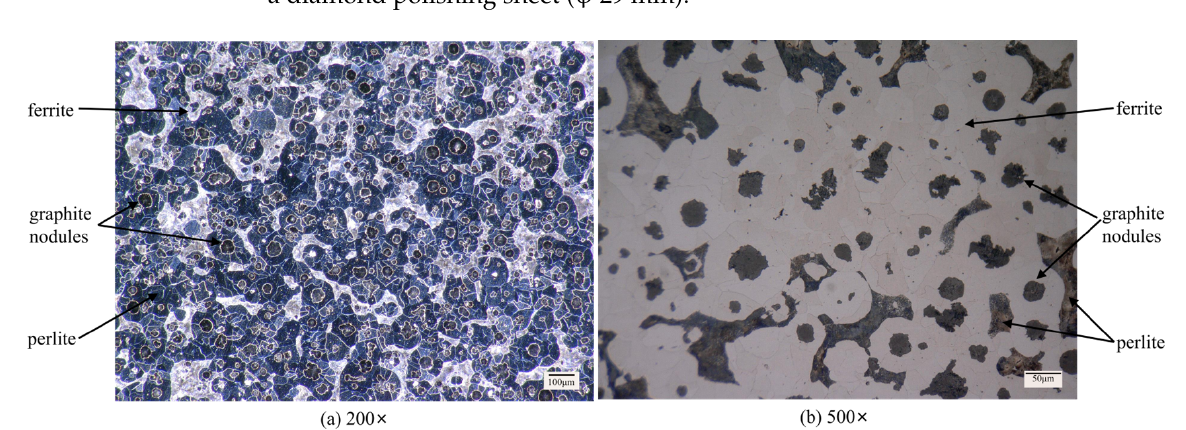
Figure 1. Microstructure of nodular cast iron QT700-2: ( a ) 200×, ( b ) 500×.